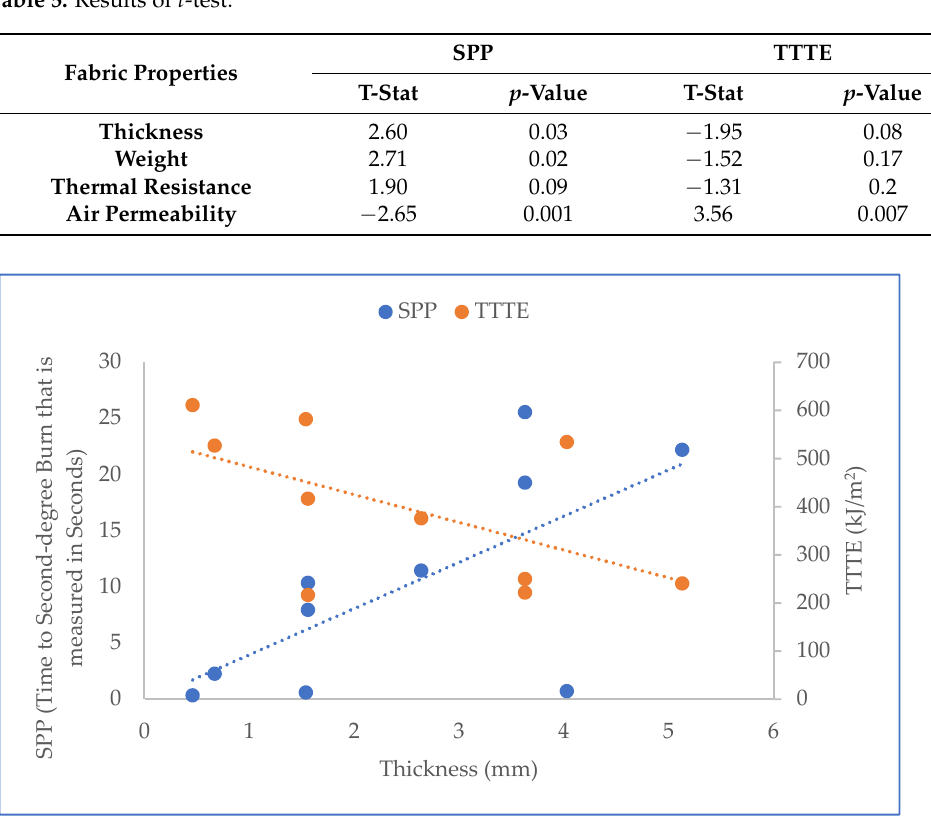
Figure 4. Relationship plot of thickness with SPP and TTTE.